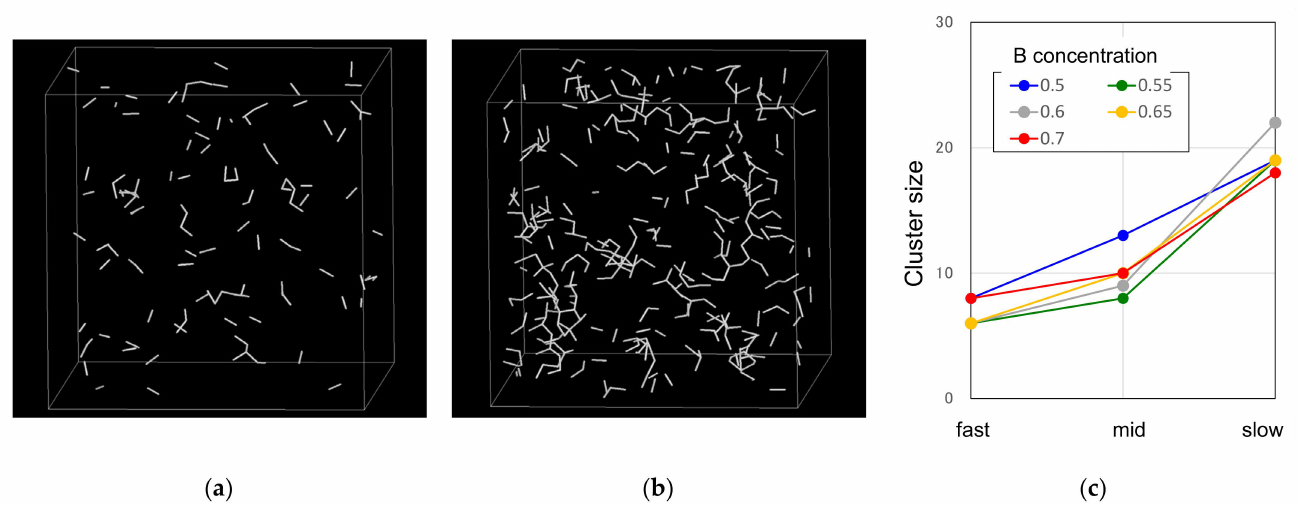
Figure 15. ( a ) Network structure of the 6-ring bonds between Z-clusters found in an r BB = 0.8 A 35 B 65 glassy phase formed by fast-cooling and ( b ) in an r BB = 0.8 A 35 B 65 glassy phase formed by slow-cooling. ( c ) Cooling rate dependence of the maximum number of connected Z-clusters by hexagonal bicap sharing in the r BB = 0.8 A 1 − x B x glassy